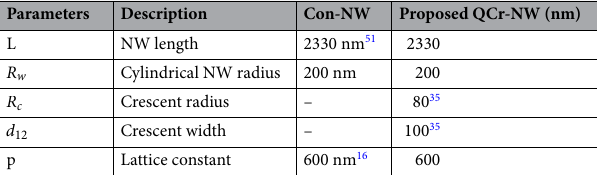
Table 1. The geometrical parameters values of the proposed and conventional solid NW structures 35 .